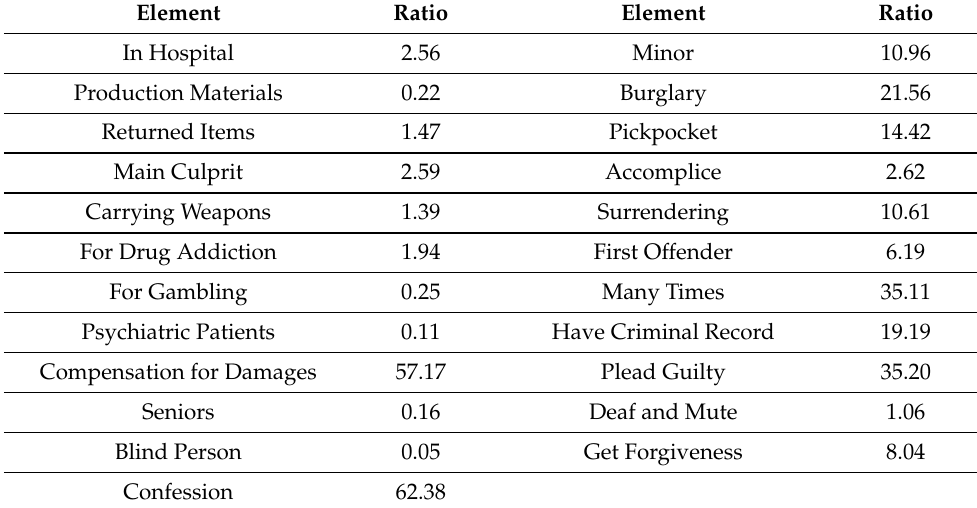
Table 1. The key circumstance elements.